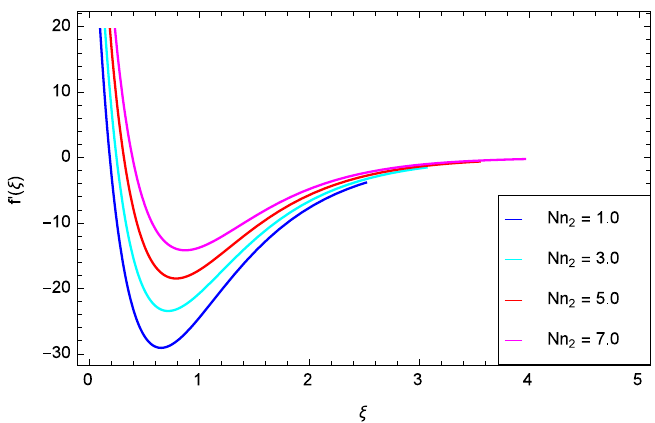
Figure 6. Impact of the non-Newtonian parameter Nn 2 on velocity f (cid:48) ( ζ ) .